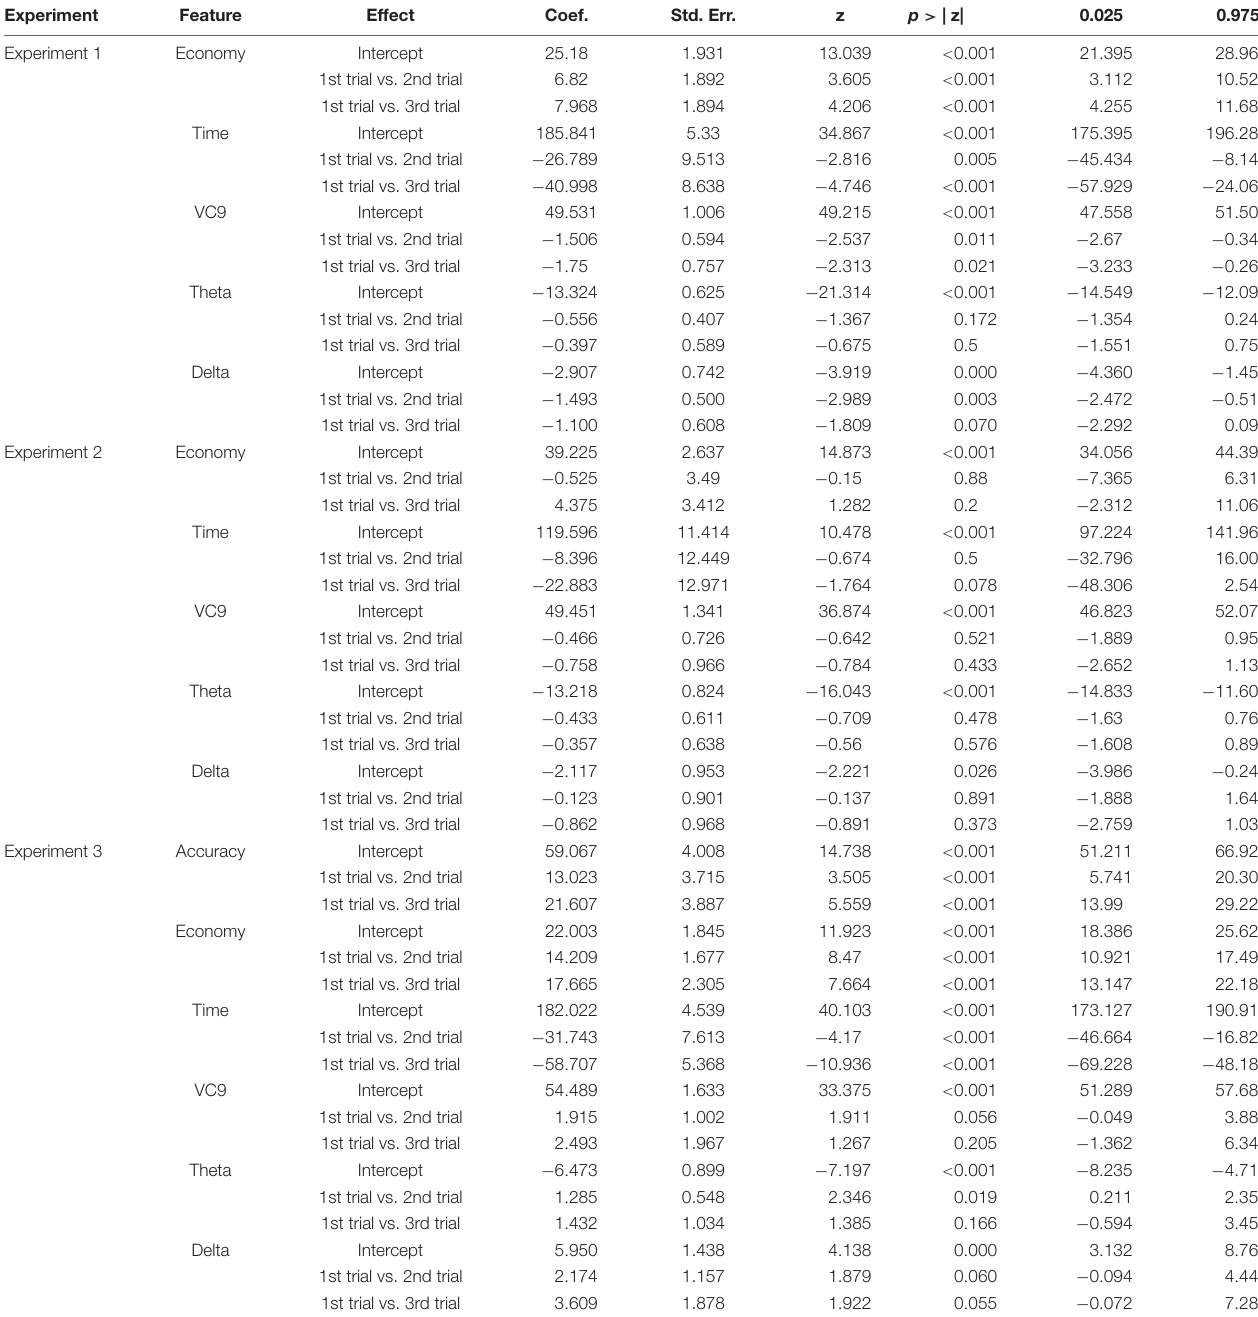
TABLE 1 | Coefficients, standard errors, Z -scores, p -values, and confidence intervals for all effects depicted in the three LMM analyses applied in the three experiments of the present study. Experiment Feature Effect Coef. Std. Err. Experiment 1